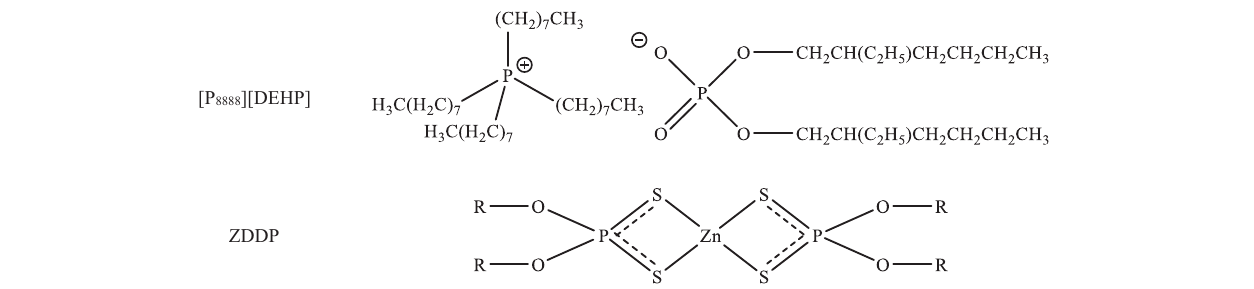
FIGURE 1 | Structures of tetraoctylphosphonium bis(2-ethylhexyl) phosphate and zinc dialkyldithiophosphate .